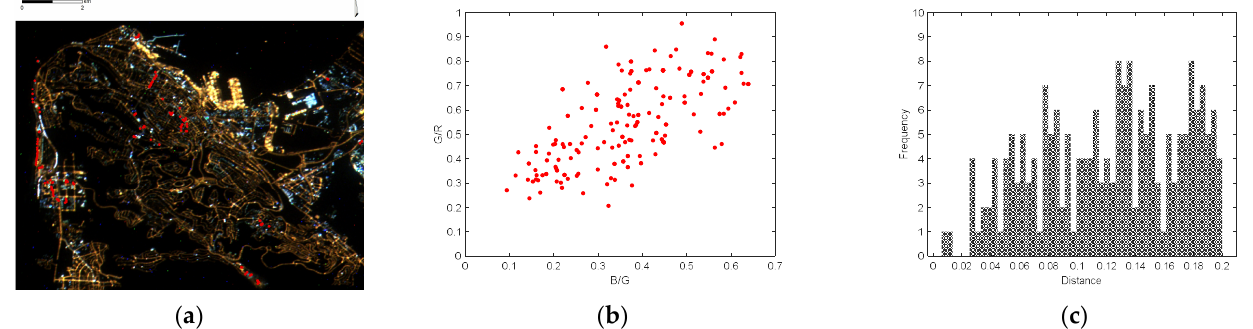
Figure 6. Main characteristics of selected representative ground truth measurements: localities (marked as red dots) ( a ), G/R and B/G ratios ( b ), and Euclidian distances distribution from the corresponding ISS pixel in G/R, B/G coordinate system ( c ).